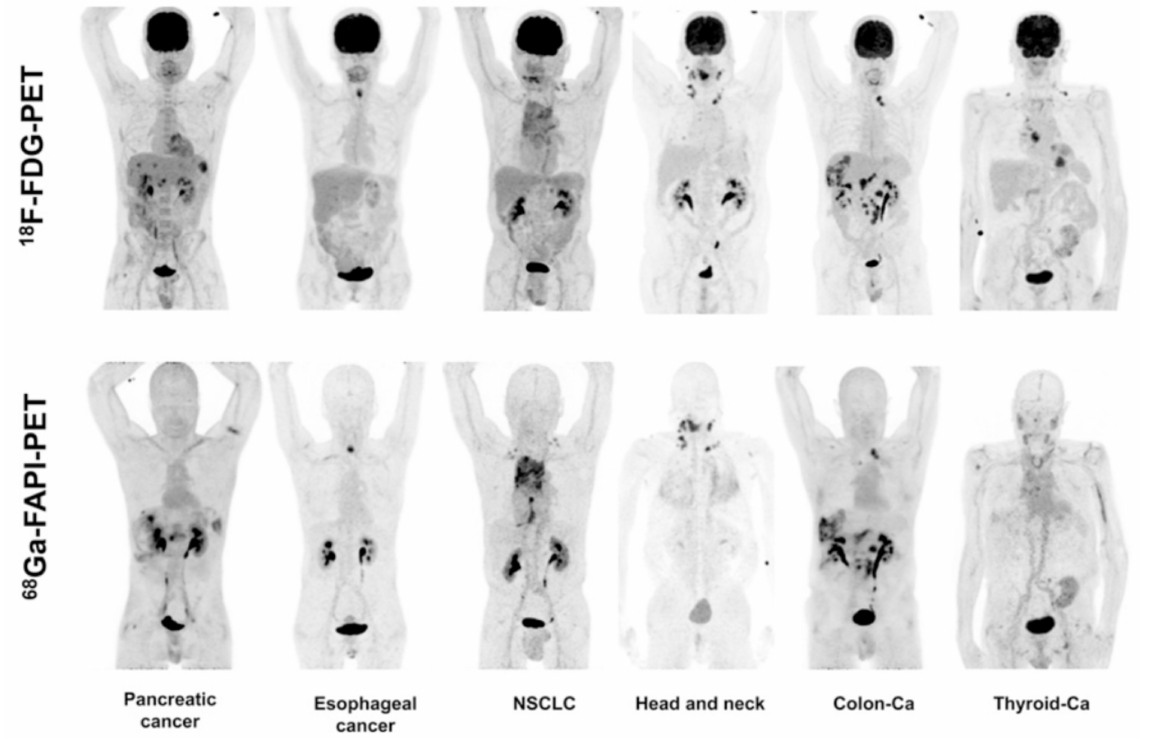
Figure 8. Whole-body PET/CT scans of six selected patients with different tumors entities imaged with [ 18 F]FDG and [ 68 Ga]Ga-FAPI-02 in the range of a 9-day imaging interval. NSCLC: non-small cell lung cancer; Ca: cancer. The figure is originally published in JNM by Giesel et al. 68 Ga-FAPI PET/CT: Biodistribution and Preliminary Dosimetry Estimate of 2 DOTA-containing FAP-Targeting Agents in Patients with Various Cancers. J Nucl Med. 2019; 60:386–392. © SNMMI